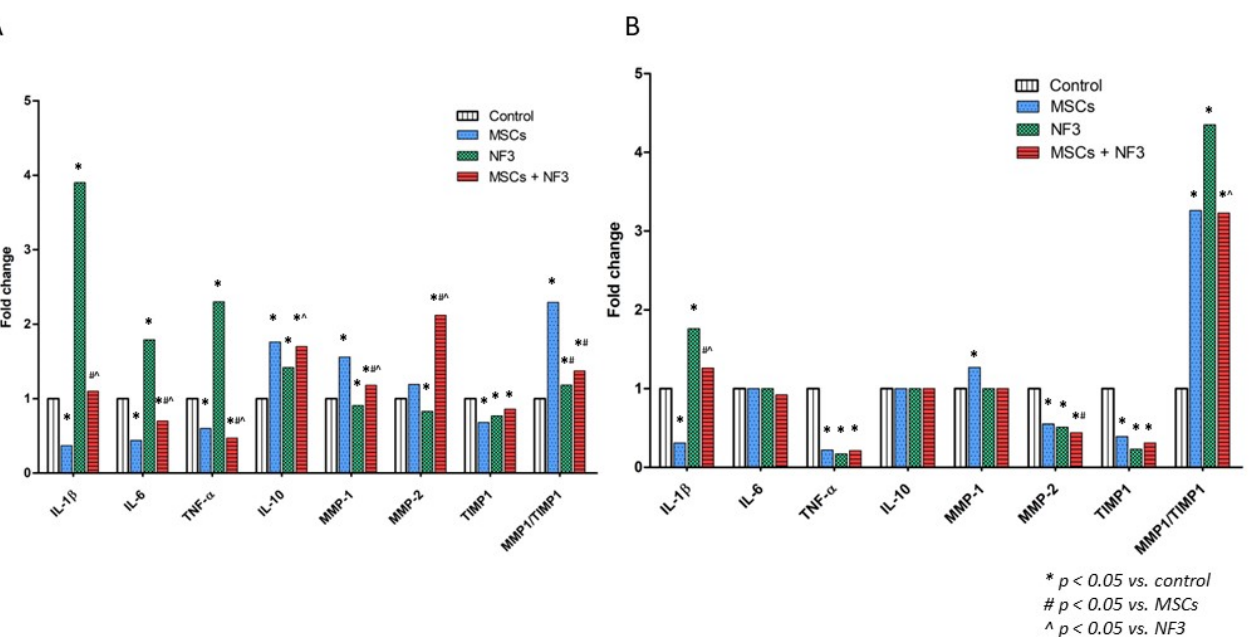
Figure 4. The expression of inflammation-related and ECM-related genes in skin. The tissues were collected 7 days and 14 days after surgery. ( A ) Gene expressions on Day 7. The expressions of anti-inflammatory genes (IL-1 β , IL-6, and TNF- α ) were downregulated in both the MSCs and MSCs + NF3 groups ( p < 0.05). Their expressions were upregulated in the NF3 group. The expression of the anti-inflammatory gene (IL-10) was upregulated significantly in all groups ( p < 0.05). In terms of ECM-related genes, the expressions of MMP-1 and MMP-2 were upregulated significantly in the MSCs and MSCs + NF3 groups ( p < 0.05), while it was downregulated in the NF3 group. The expression of its inhibitor, TIMP1, was downregulated significantly in all groups ( p < 0.05). After calculating the ratio of MMP1 to TIMP1, it was clear that this increased significantly in all groups ( p < 0.05). ( B ) Gene expression on Day 14. The expression of IL-1 β was downregulated significantly in the MSCs group ( p < 0.05). Its expression was upregulated in the NF3 and MSCs + NF3 groups ( p < 0.05). The expression of TNF- α was downregulated remarkably in all groups ( p < 0.05). No difference was observed in the expression of IL-6 or IL-10. The expression of MMP-1 was upregulated only in the MSCs group ( p < 0.05). The expression of MMP-2 and TIMP-1 was downregulated significantly in all groups ( p < 0.05). After calculating the ratio of MMP1 to TIMP1, it was clear that this increased significantly ( p < 0.05).